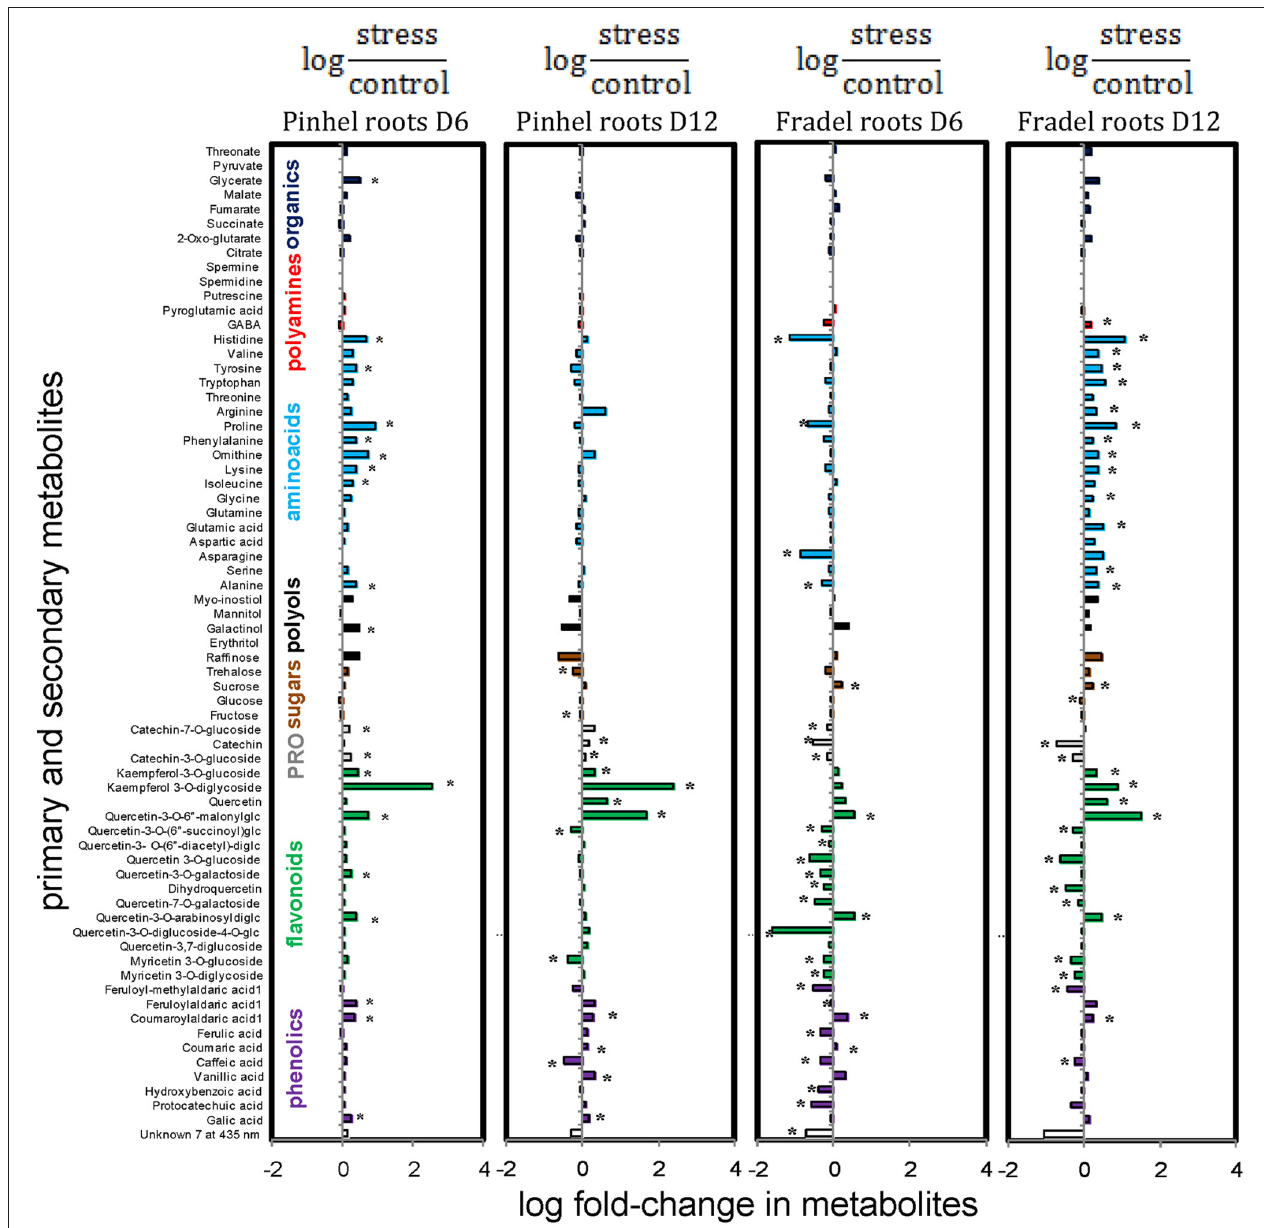
FIGURE 11 | Effects of drought stress on cowpea root metabolites. Data are presented as averaged logarithmic fold-change ratios of metabolite levels in drought-stressed and control plants. Unidentified and undetected metabolites (with the exception of unknown7) are omitted for visual clarity. PRO = proanthocyanidins. Measurements were taken on day 6 (D6) or 12 (D12) of water stress ( n = 4–6). Negative values represent reduced and positive values increased metabolite content in the stressed plants, with asterisks indicating statistical differences ( t -test; P < 0.05).